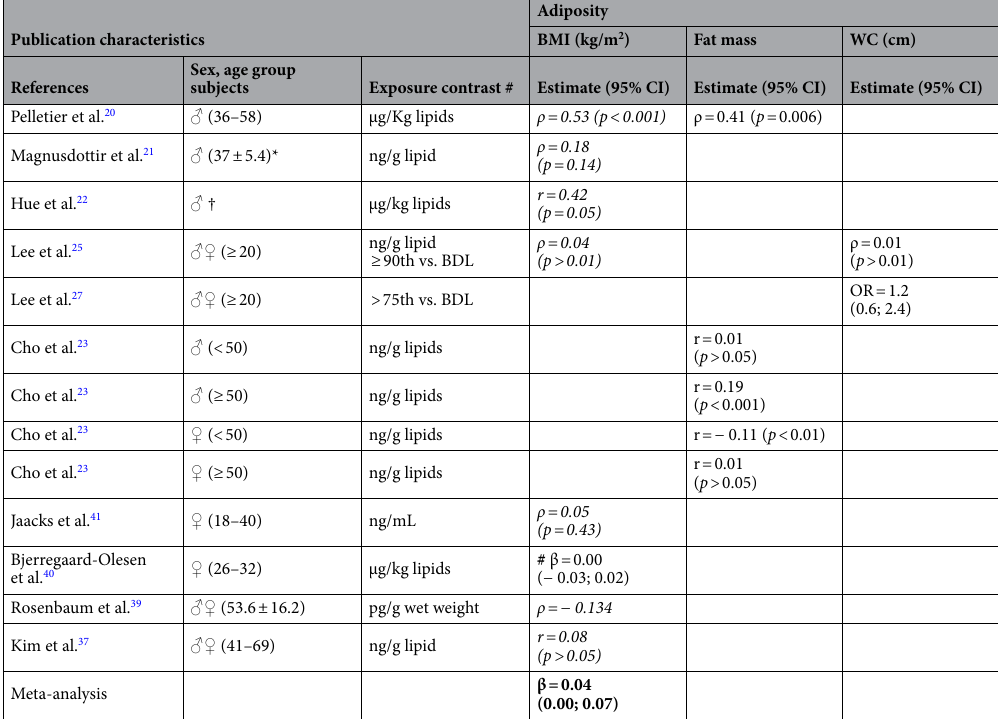
Table 1. Description of all found associations between oxychlordane and each adiposity measure. BMI, Body Mass Index; WC, Waist Circumference; β, Beta coefficient; OR, Odds Ratio; ρ, spearmen correlation, r, Pearson correlation; * Mean; †, Without information; # Pre pregnancy-BMI as outcome; italic values represents studies for which was possible to perform a meta-analysis